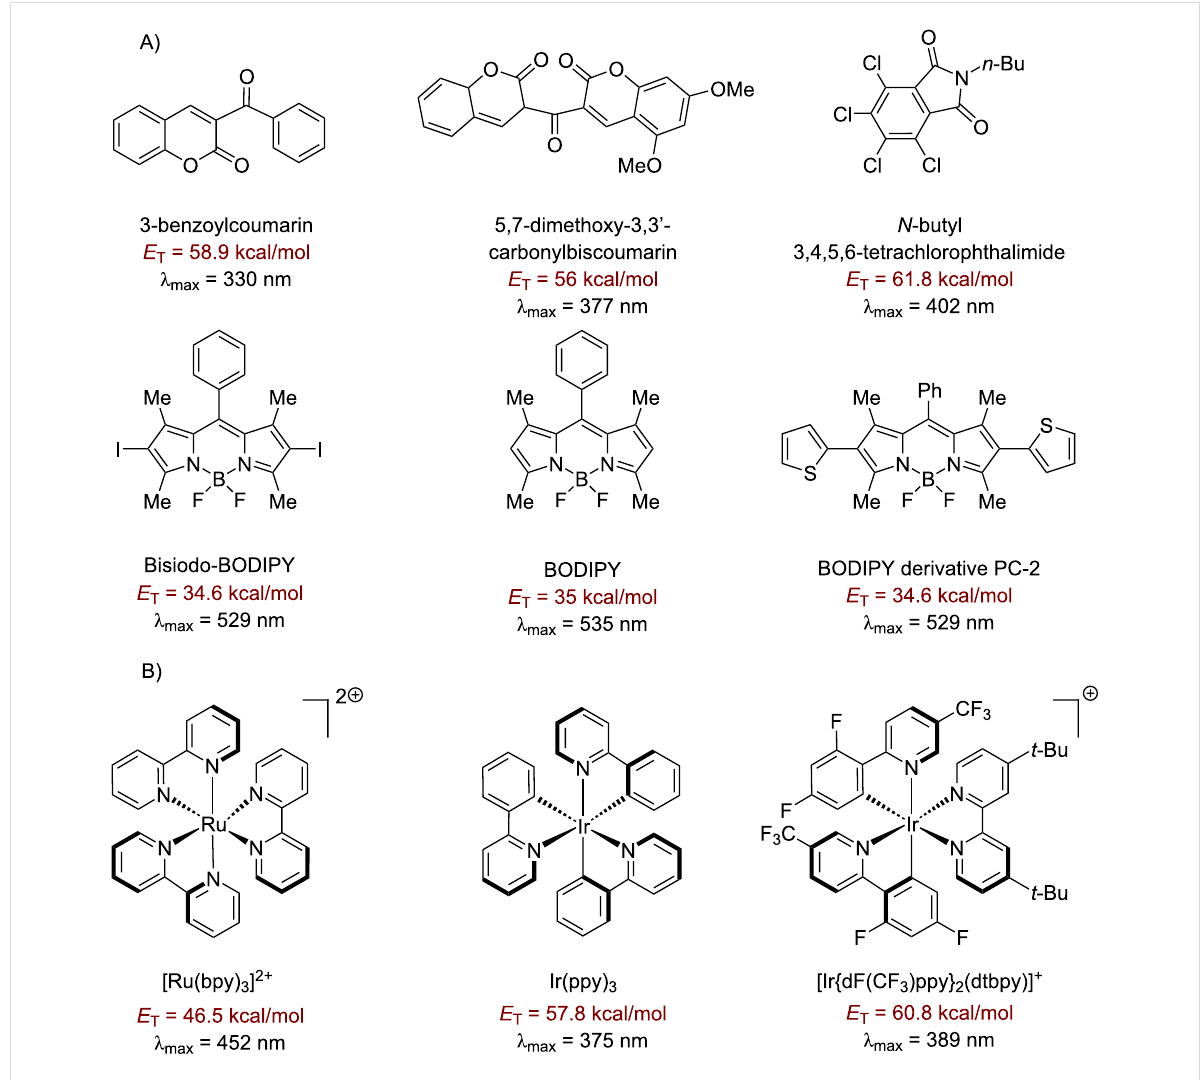
Figure 7: A) Further organic triplet PSCats and B) transition metal triplet